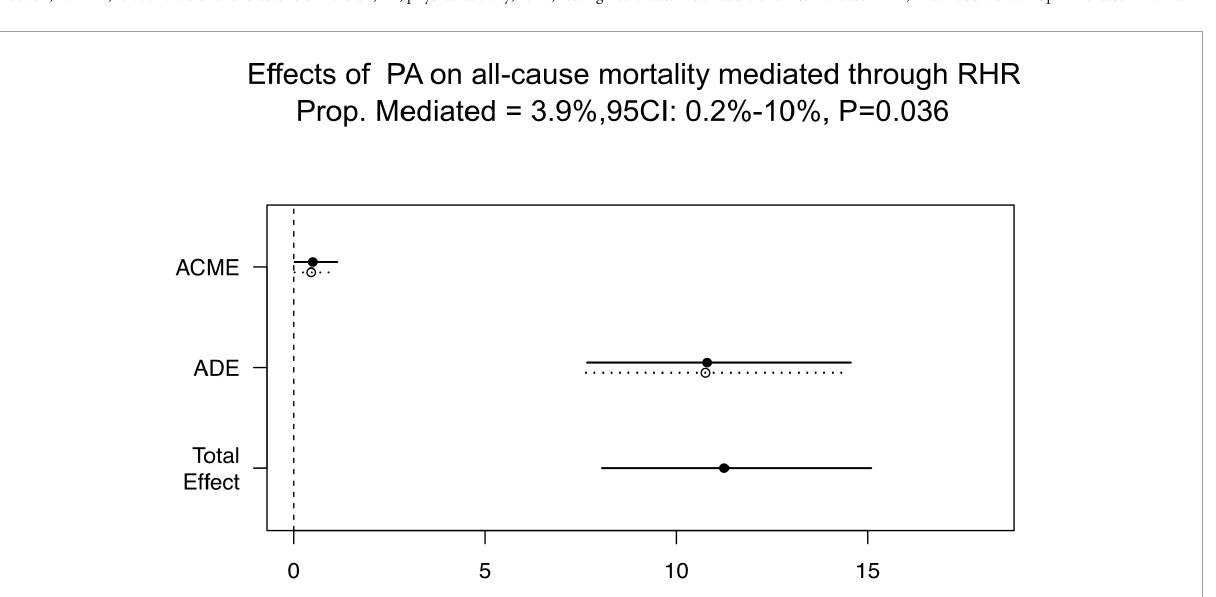
FIGURE5 Causal mediation analysis results. ACME, average causal mediation effect; ADE, average direct effect; CI, confidence interval; PA, physical activity; RHR, rest heart rate; Prop. Mediated, mediation